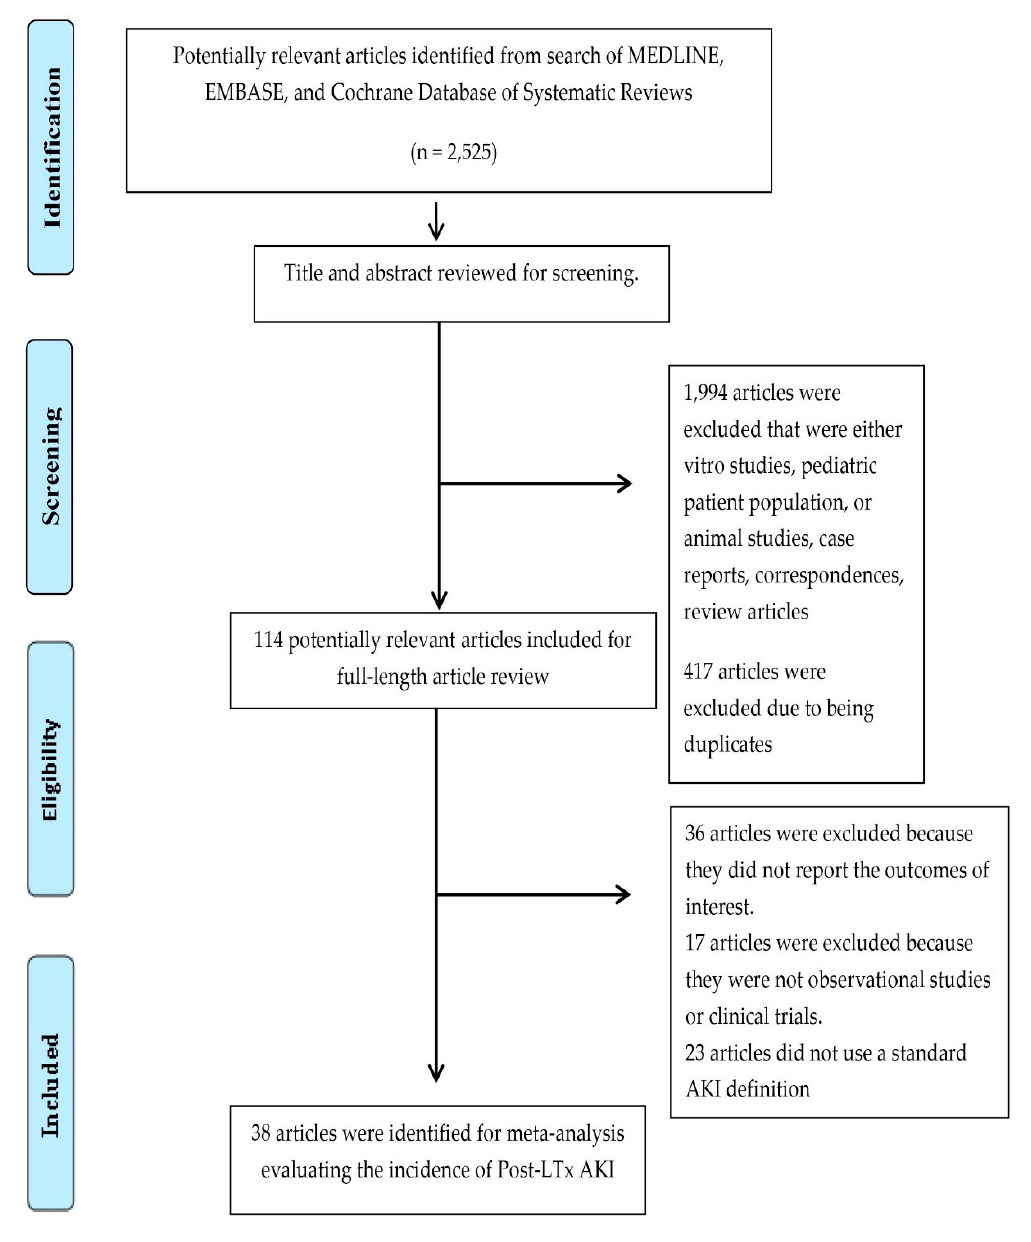
Figure 1. Outline of our search methodology.